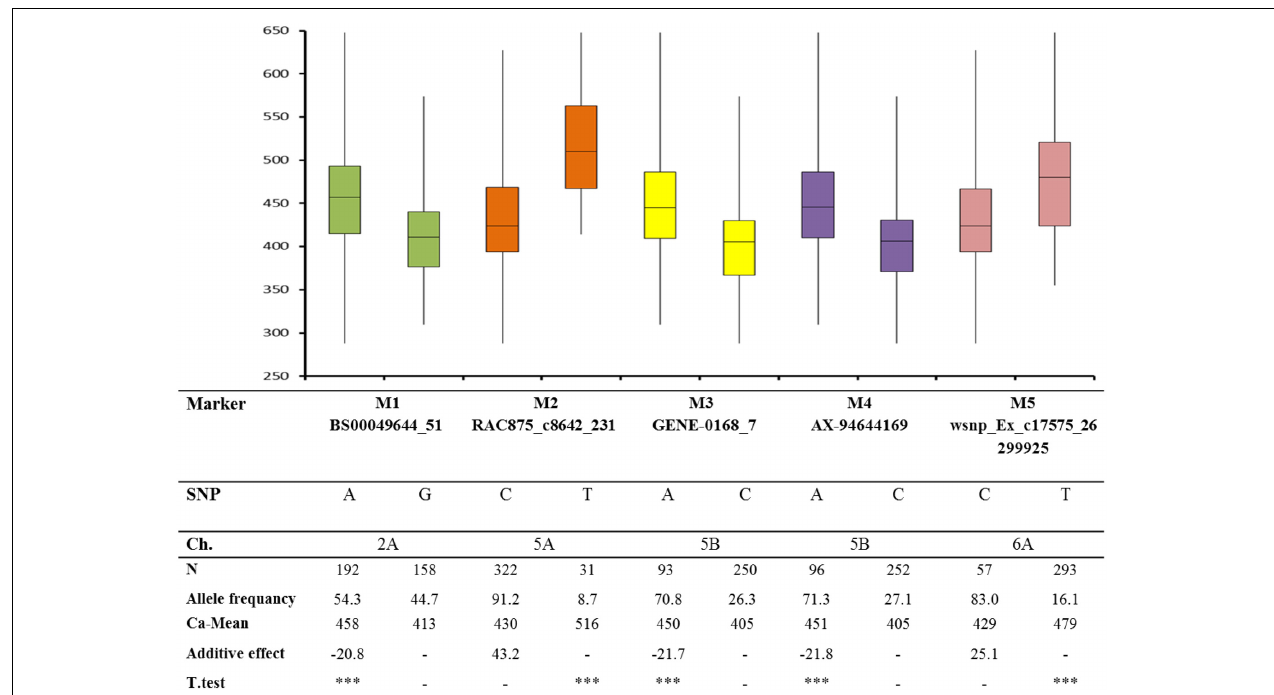
FIGURE 4 | Box plot analysis for five significant markers based on BLUEs for calcium trait (MAF = AF). ∗∗∗ denotes